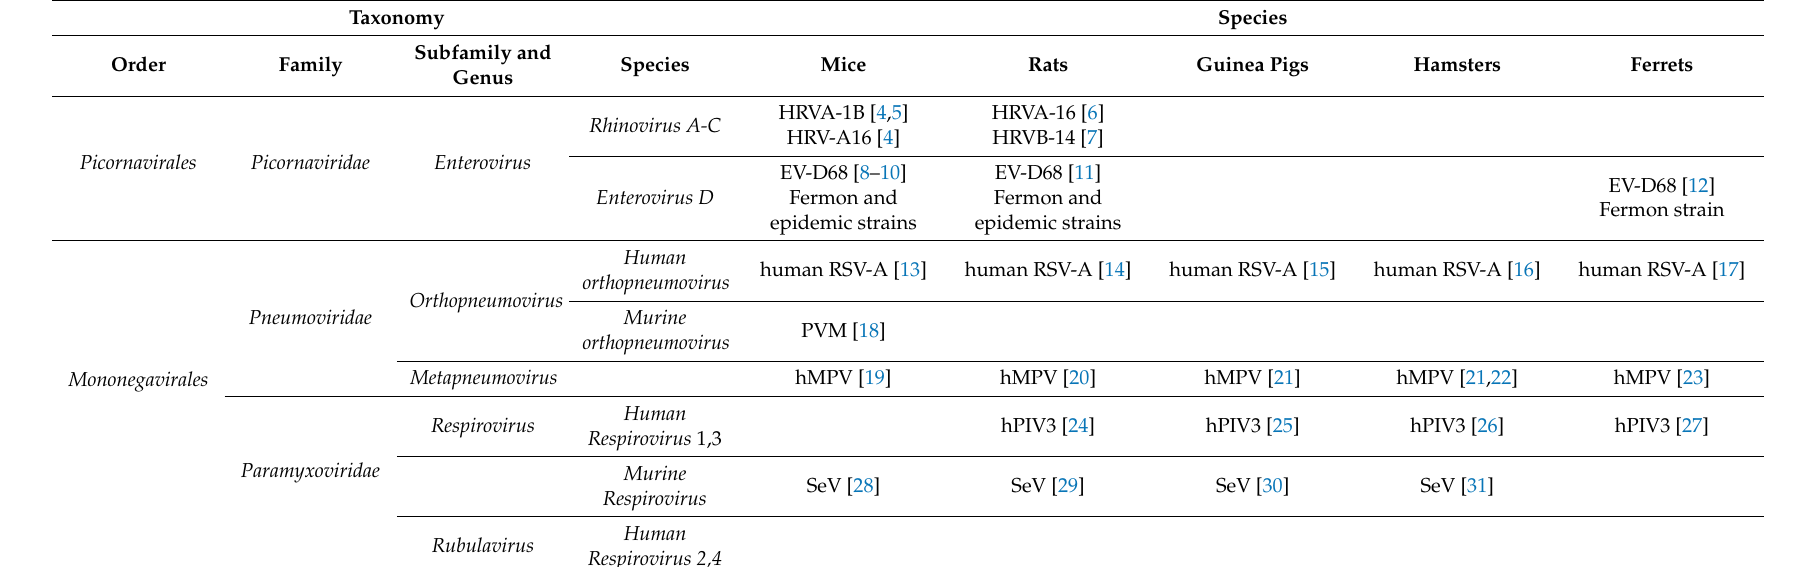
Table 1. Asthma-associated respiratory viruses and infection susceptibility in small